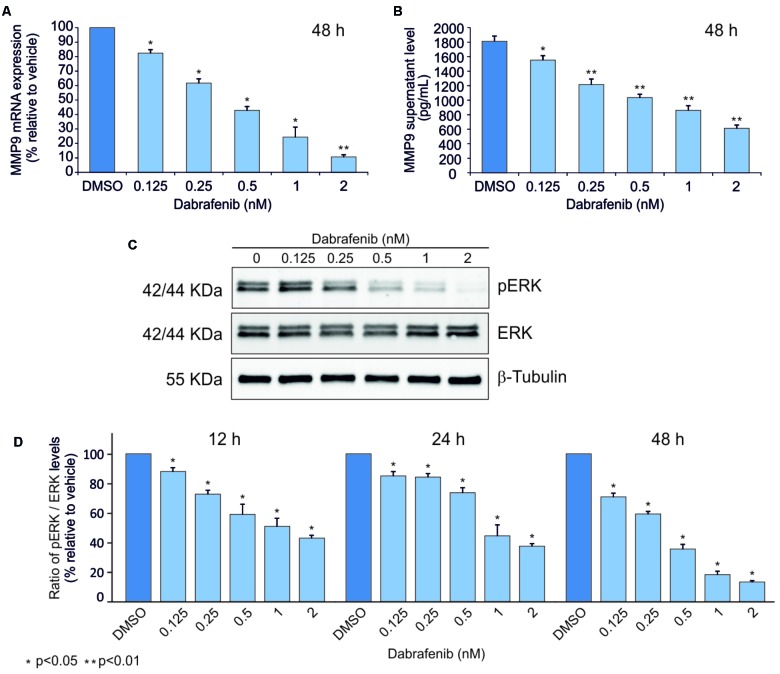
Dabrafenib treatment of A375 cell line. MMP-9 expressionlevels were evaluated by qPCR (A) and ELISA Assay (B) in A375 cell line treated with increasing doses of dabrafenib (0.125, 0.25, 0.5, 1, and 2 nM) for 48 h. pERK and total ERK protein levels were evaluated by Western blot analysis after treatment with dabrafenib for 12, 24, and 48 h (C,D). The statistical significance of the two-tailed Student’s t-test was referred to the control. ∗p < 0.05; ∗∗p < 0.01.